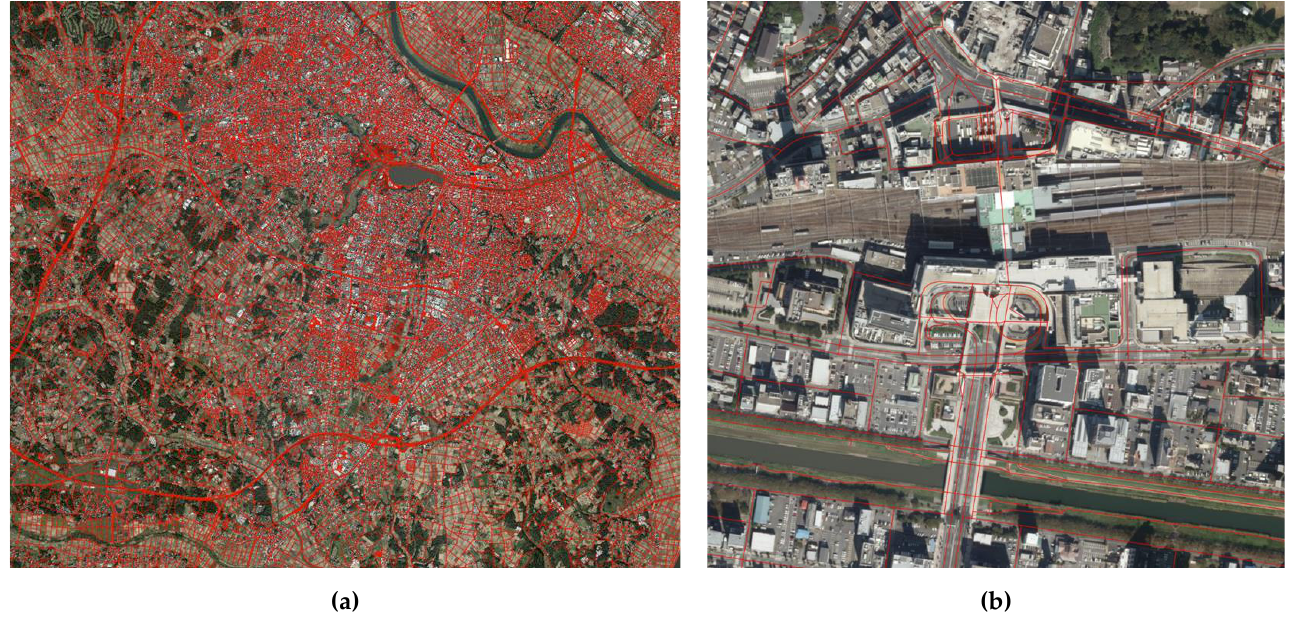
Figure 5. OSM road vector map overlaid with red lines on new-period aerial photo: (a) image of entire Mito area and (b) enlarged image around Mito Station.